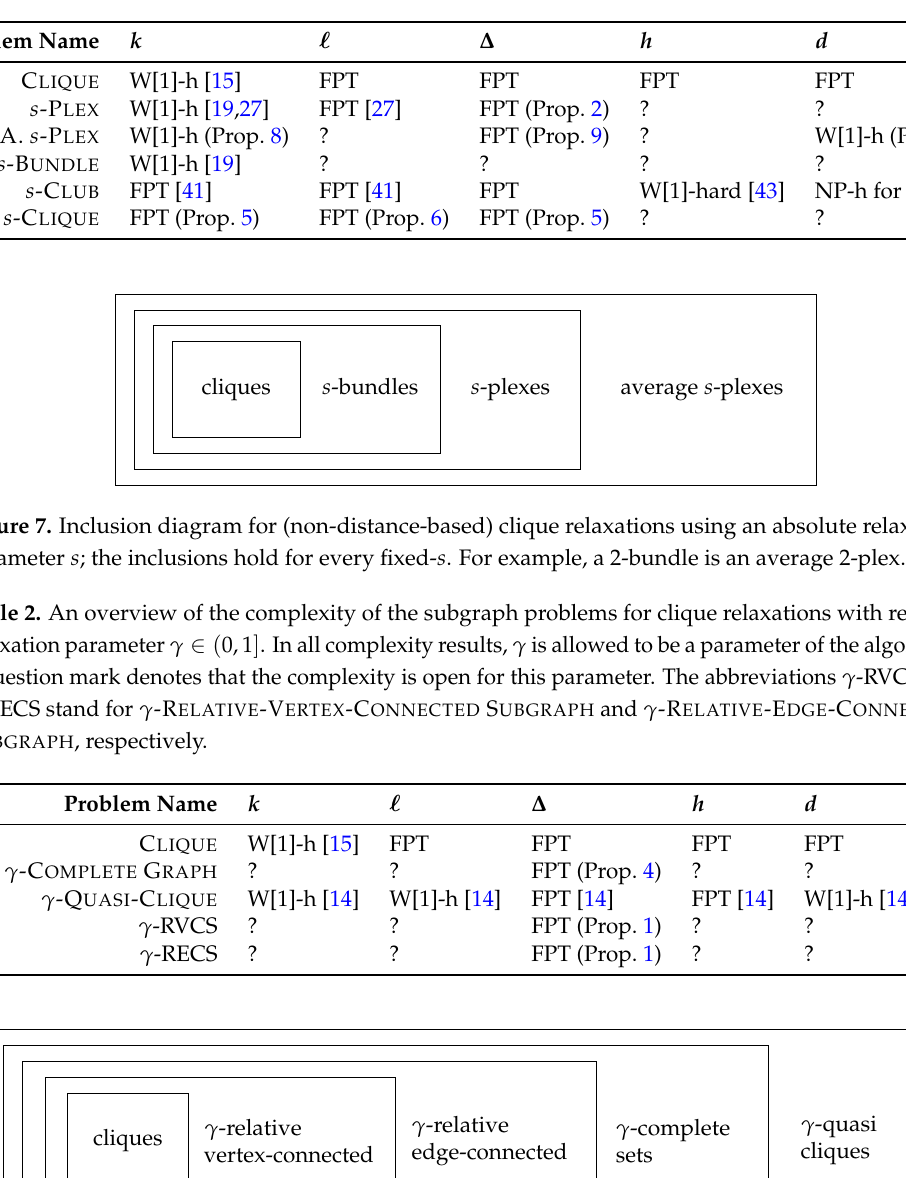
Table 1. An overview of the complexity of the subgraph problems for clique relaxations with absolute relaxation parameter s > 1. In all complexity results, s is allowed to be a parameter of the algorithm; a question mark denotes that the complexity is open for this parameter.